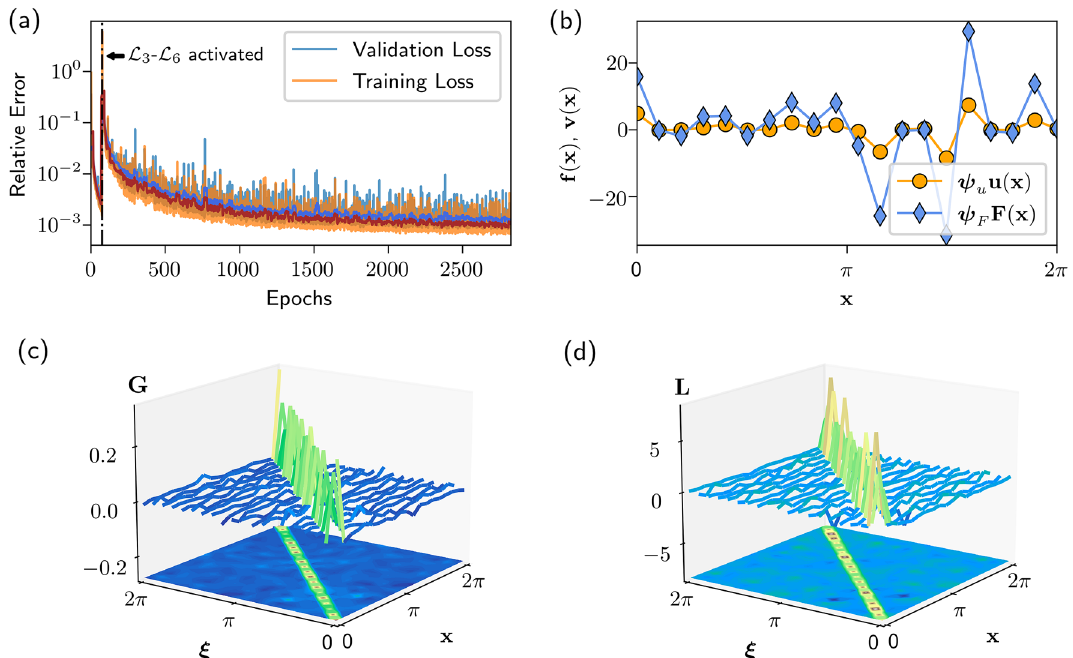
Figure 5. ( a ) Learning curve. This is a typical learning curve for the DeepGreen architecture. The vertical dashed line indicates where the training procedure transitions from autoencoders-only (only L 1 and L 2 ) to a full-network training procedure (all losses). ( b ) Latent space representations v k and f k . The autoencoder transformation ψ u encodes u k to the latent space, producing the vector v k (orange). The forcing vector F k is transformed by ψ F to the encoded vector f k (blue). ( c,d ) Visualized operator and Green’s function. Discovered 1 Green’s function G = L − and corresponding linear operator L